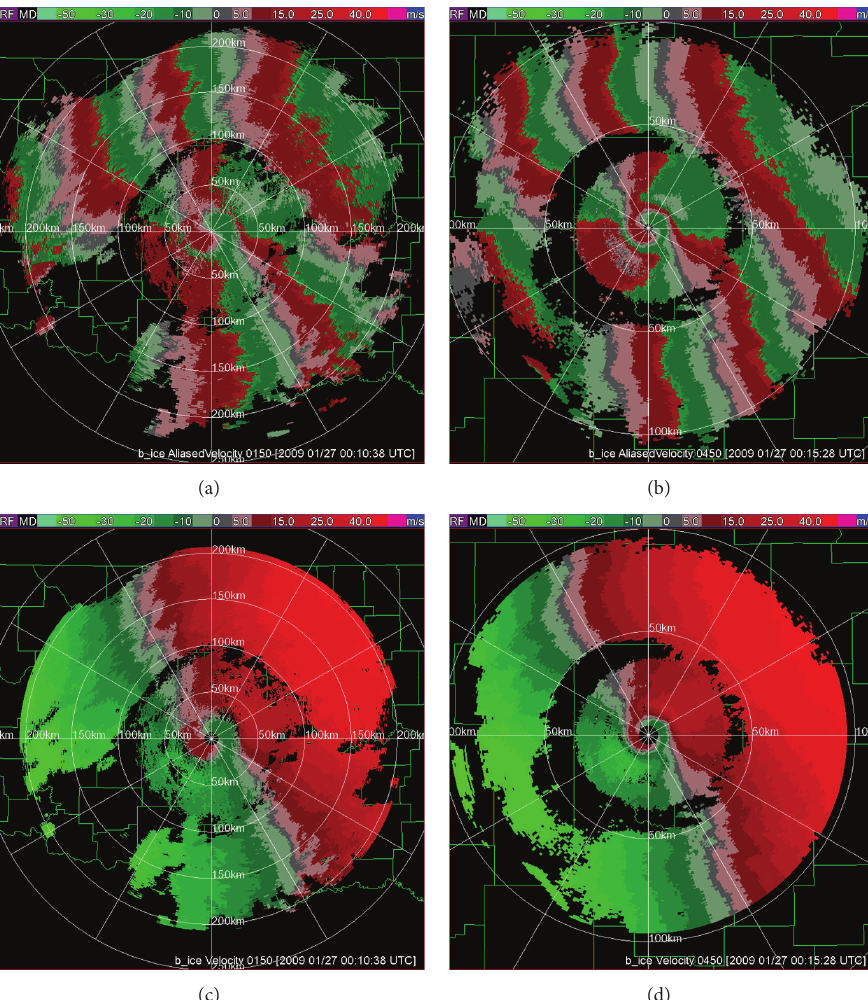
Figure 1: Raw velocity image scanned by the KTLX radar with V 𝑁 = 11.51ms −1 (a) on 1.5 ∘ tilt at 00:10:38 UTC and (b) on 4.5 ∘ tilt at 00:15:28 UTC for the ice storm on January 27, 2009. Dealiased velocity image on (c) 1.5 ∘ and (d) 4.5 ∘ tilts by the AR-Var-based